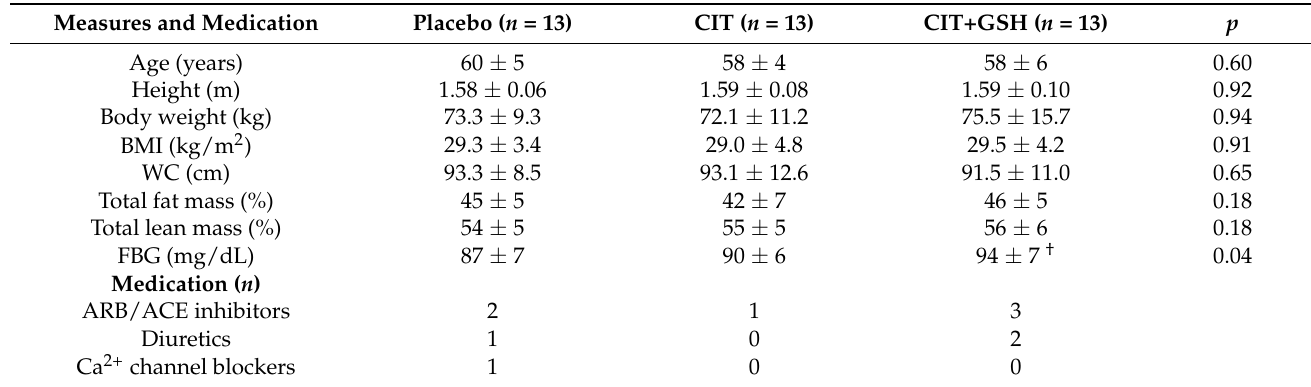
Table 1. Participant characteristics and